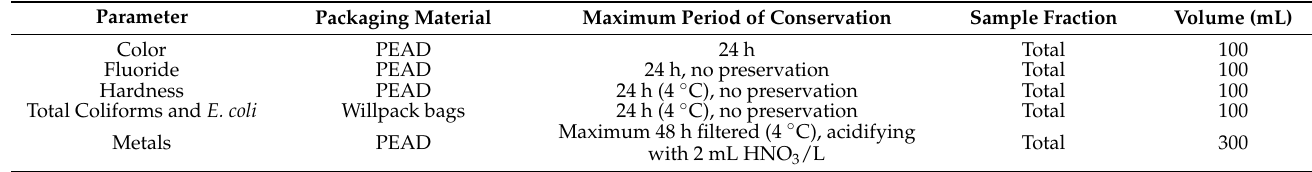
Table 2. Description of sampling for laboratory